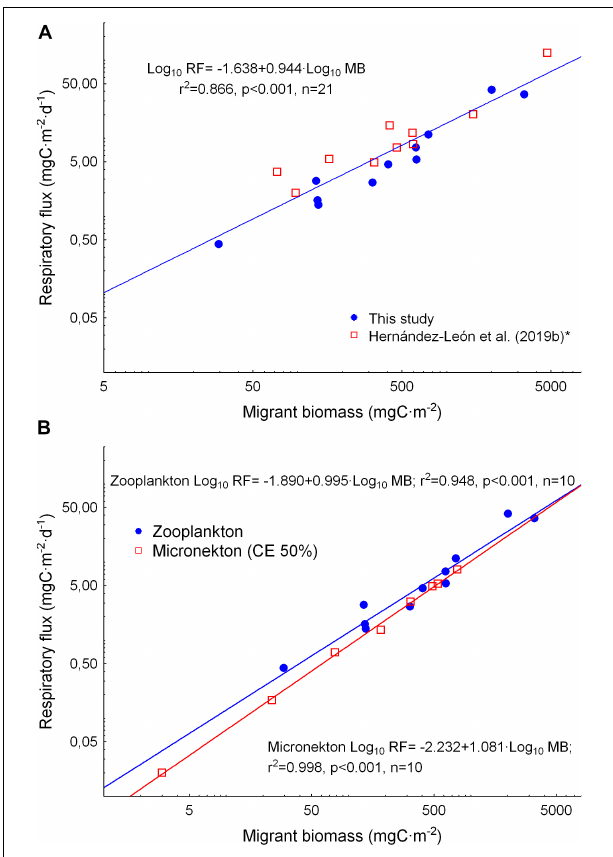
FIGURE 9 | (A) Active flux by zooplankton and micronekton using a 50% capture efficiency for the Mesopelagos trawl, and total active flux by both communities. (B) Comparison between total active flux and POC flux, and estimated total flux. Micronekton active flux for stations 4, 5, 8, and 10 were estimated from zooplankton active flux (see